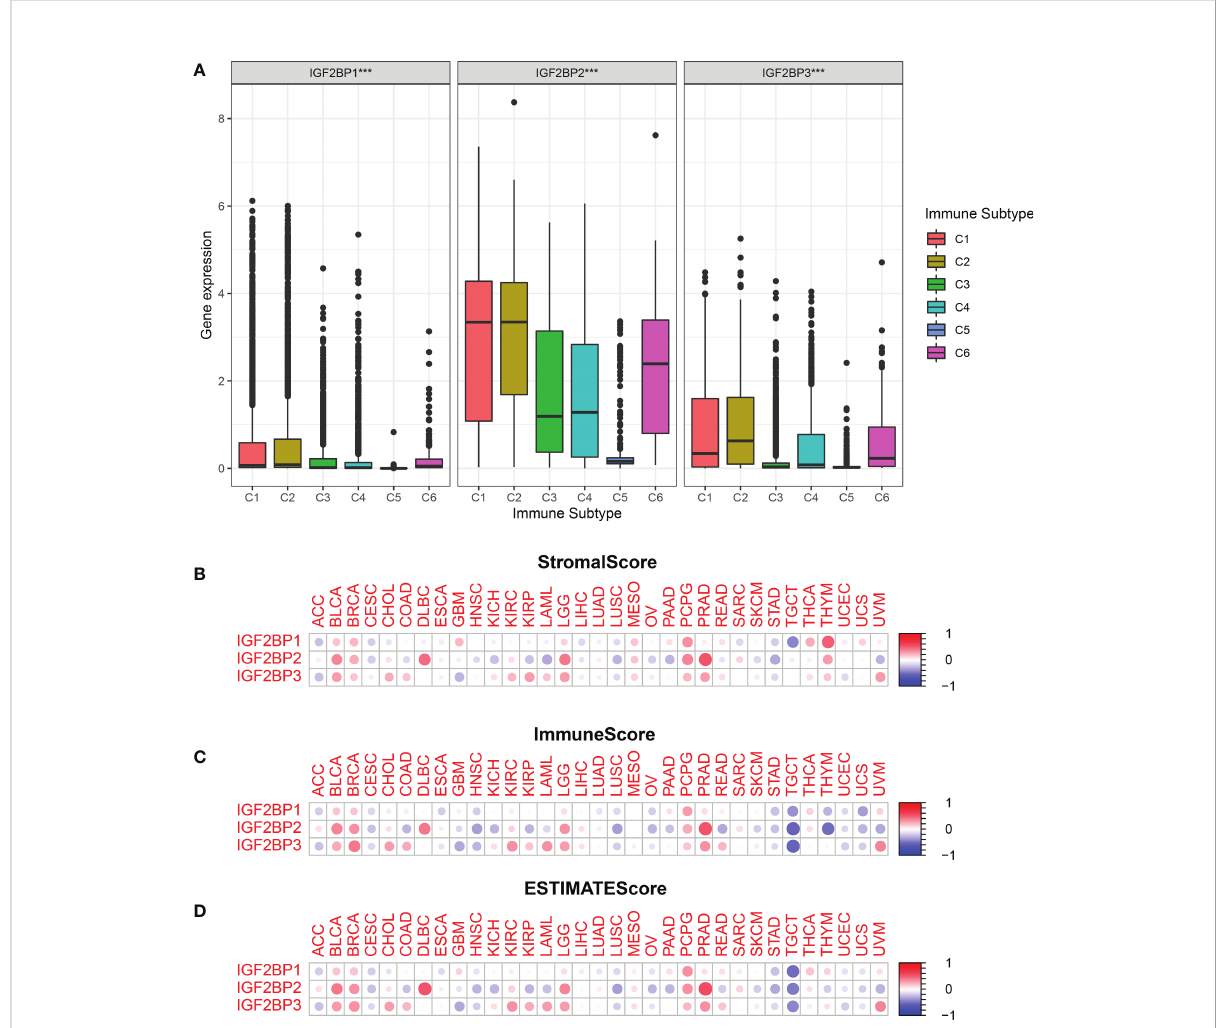
FIGURE 5 Relationship between the expression of the IGF2BPs and the tumor immune microenvironment. (A) Relationship between the expression of the IGF2BPs and the in fi ltrating immune sub-types in pan-cancer. C1: wound healing, C2: INF-r dominant, C3: in fl ammatory, C4: lymphocyte depleted, C5: immunologically quiet, and C6: TGF b dominant. The correlation matrix of the IGF2BPs expression and (B) the stromal cells, (C) the immune cells, (D) as well as comprehensive scores of 33 cancer types based on the estimation algorithm. ***P <